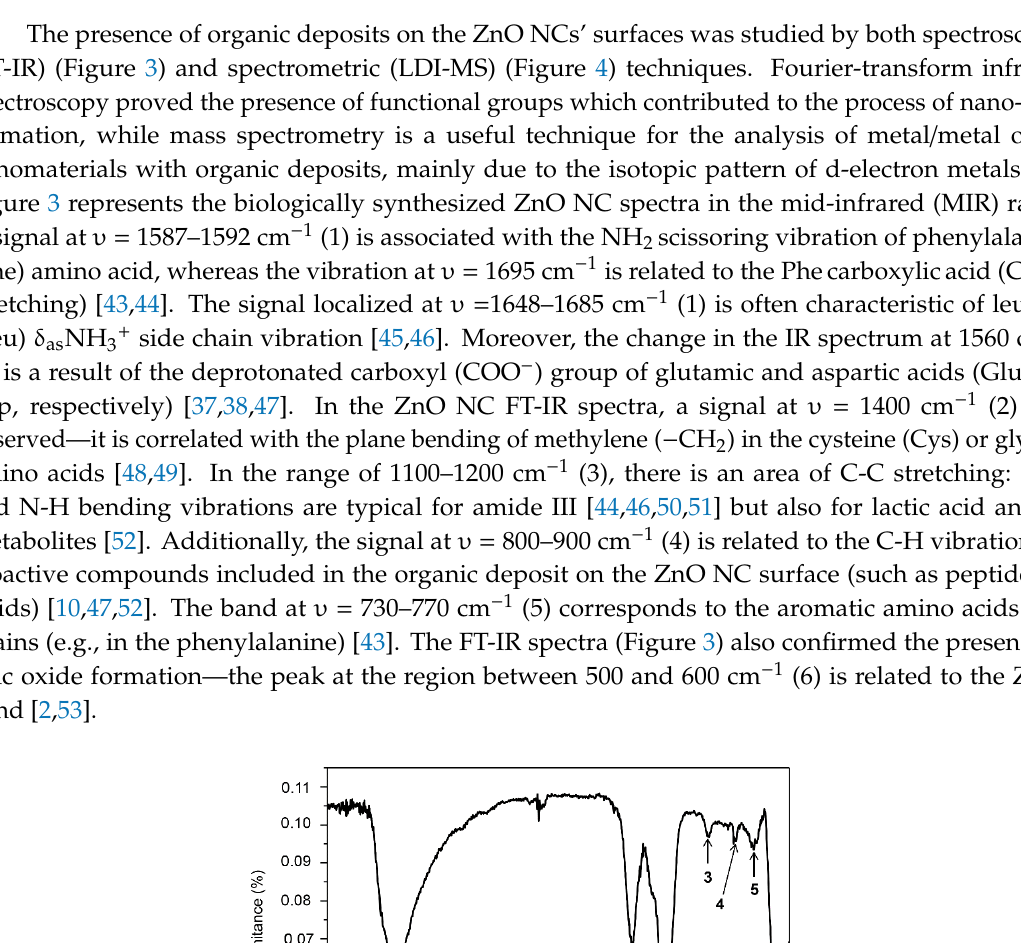
Figure 2. XRD pattern of biologically synthesized ( A ), reference ZnO NCs ( B ) and control ( C ).